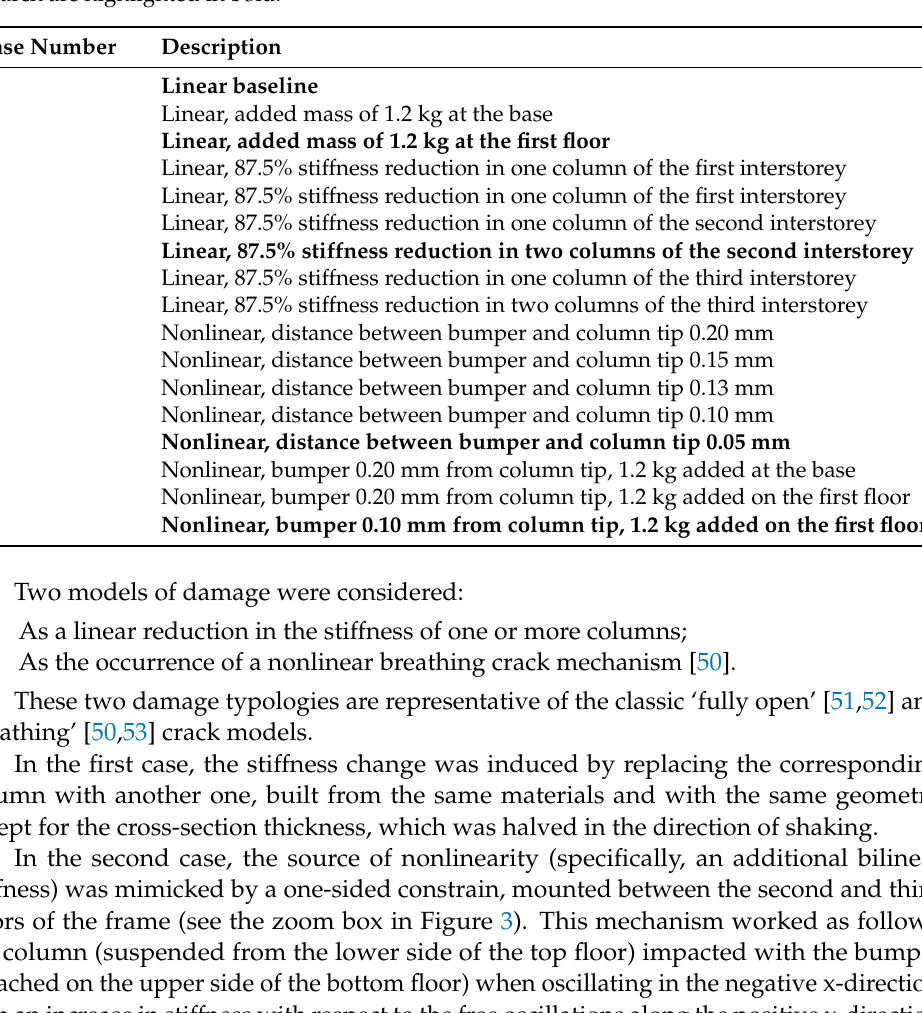
Table 1. Damaged and undamaged scenarios for the LANL frame structure. The ones used for this research are highlighted in